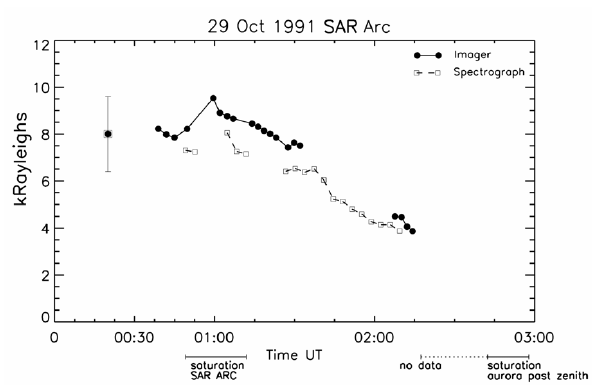
Figure 6. Independent calibration results for the all-sky imager and the meridional imaging spectrograph operating at Millstone Hill on the night of 29 October 1991. The curves give the total above sky-background brightness values vs UT from each instrument: for the spectrograph this is the brightest value of the SAR arc along the north-south meridian; for the imager it is the brightness value at the corresponding spatial location and time. The uncertainty levels for each system ultimately depend on the 14 C standard source that has a ~20% variation within its disk, and so a 20% “uncertainty” bar is indicated.